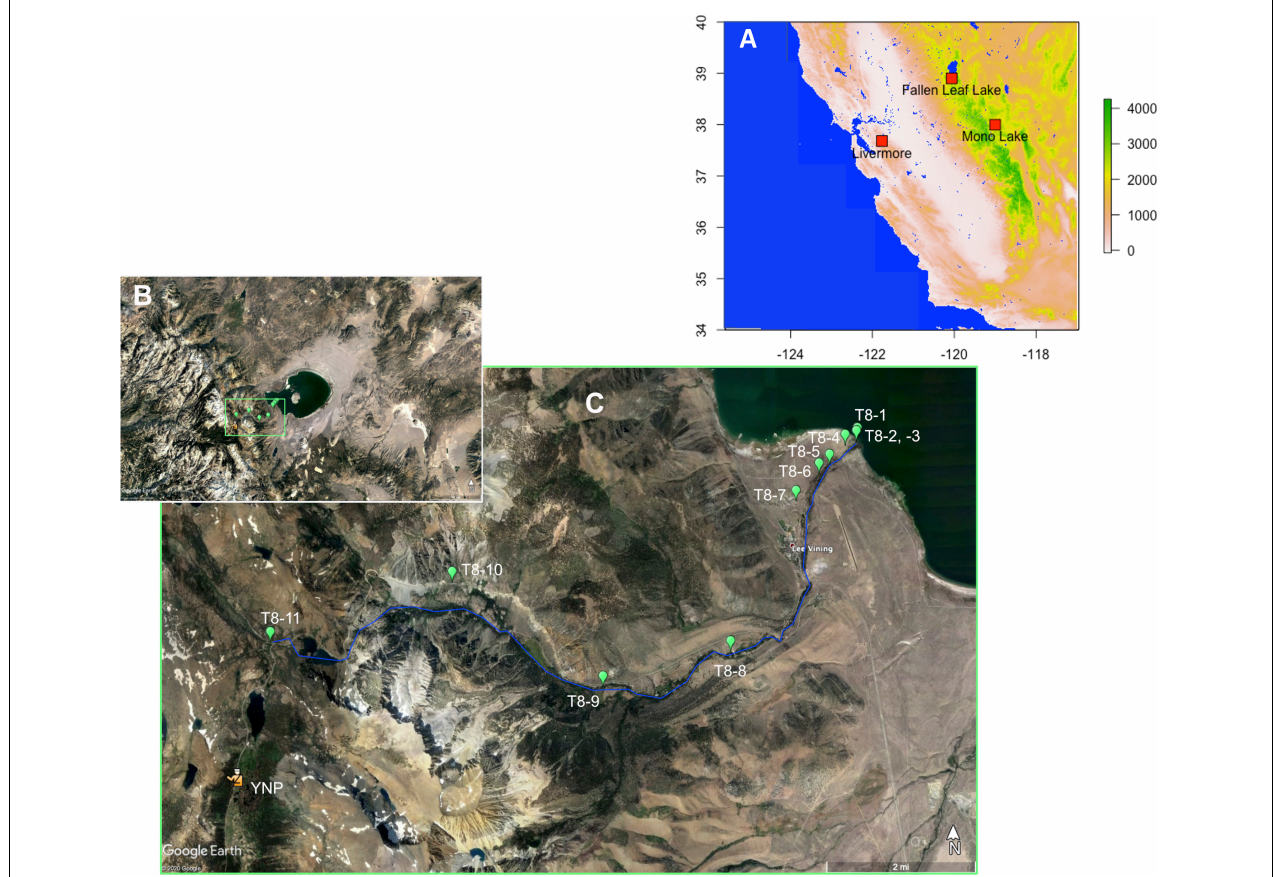
FIGURE 1 | (A) Map of California, United States, showing the locations of the Mono Lake, Fallen Leaf Lake, and Livermore sites. (B) Google Earth image of Mono Lake, showing the exposed glacial-age lake bed surrounding the modern lake, and the stream canyons supplying mountain snowmelt from the Sierra Nevada to Mono Lake. (C) Detail of (B) showing transect #8 (T8), with green markers show the sampling points along the transect. Samples T8-2 and T8-3 were taken at the same coordinates, with T8-2 taken at the lake shore, and T8-3 slightly inland. The location of Lee Vining Creek is shown roughly by the blue line; all sampling locations were on the north side of the creek. The east entrance to Yosemite National Park is indicated for reference